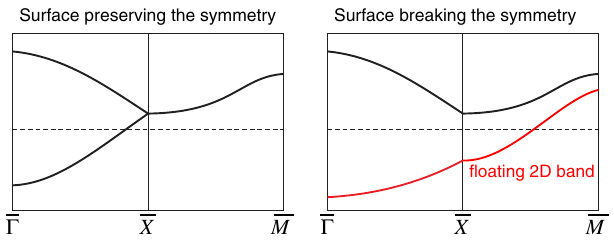
FIG. 1. Schematic of the surface states possible in nonsym- morphic materials, as occurrent in ZrSiS. The symmetry enforce- ment of the band degeneracy at X is relaxed at the surface, creating a sizable energy separation between the surface band (red line) and bulk bands (black lines). With minimal coupling between them, the two-dimensional surface band can be seen as “ floating ” in an energy region not accessible to bulk